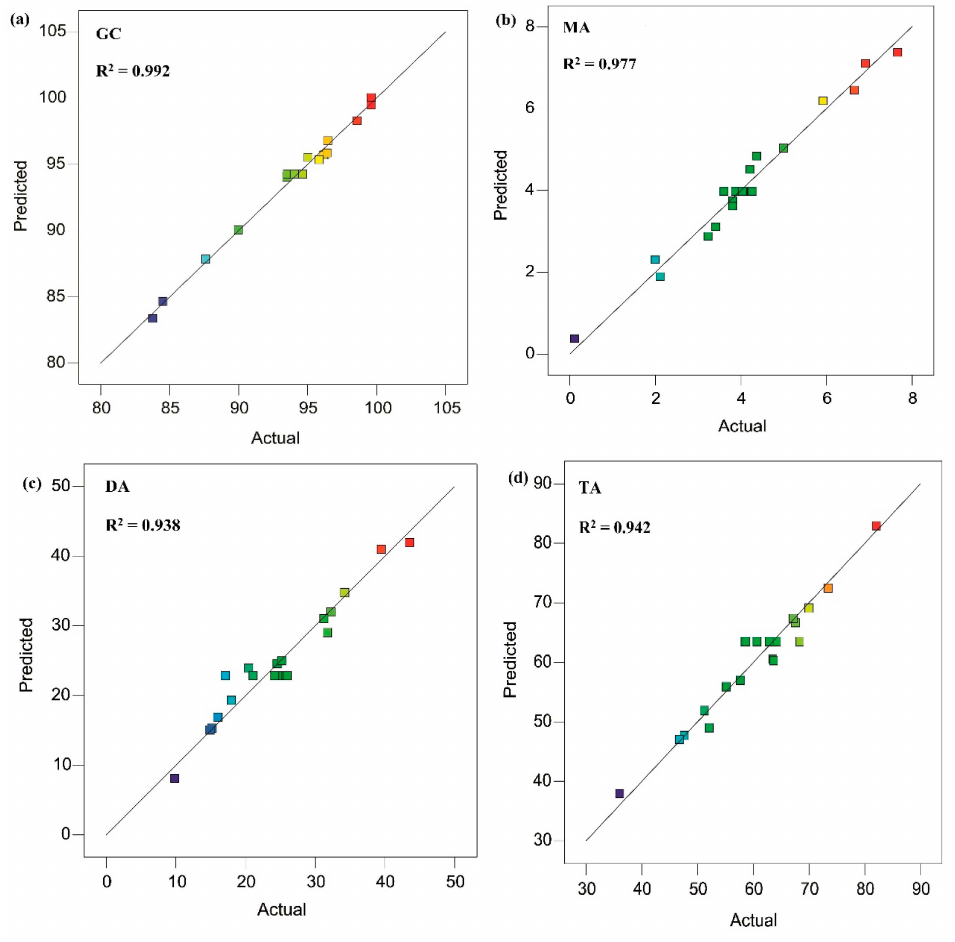
Figure 10. Parity plot for ( a ) glycerol conversion (GC) ( b ) monoacetin (MA) ( c ) diacetin (DA) and ( d ) triacetin (TA)